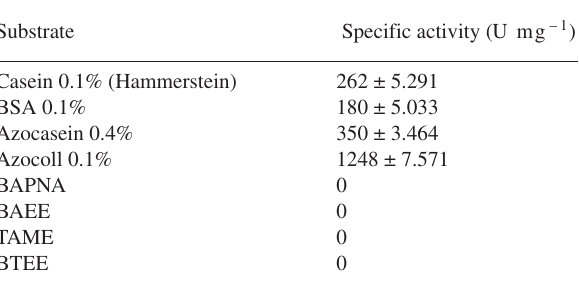
Table 4. Substrate specificity of purified protease. Specific activity values are means of triplicate determinations ± SD.